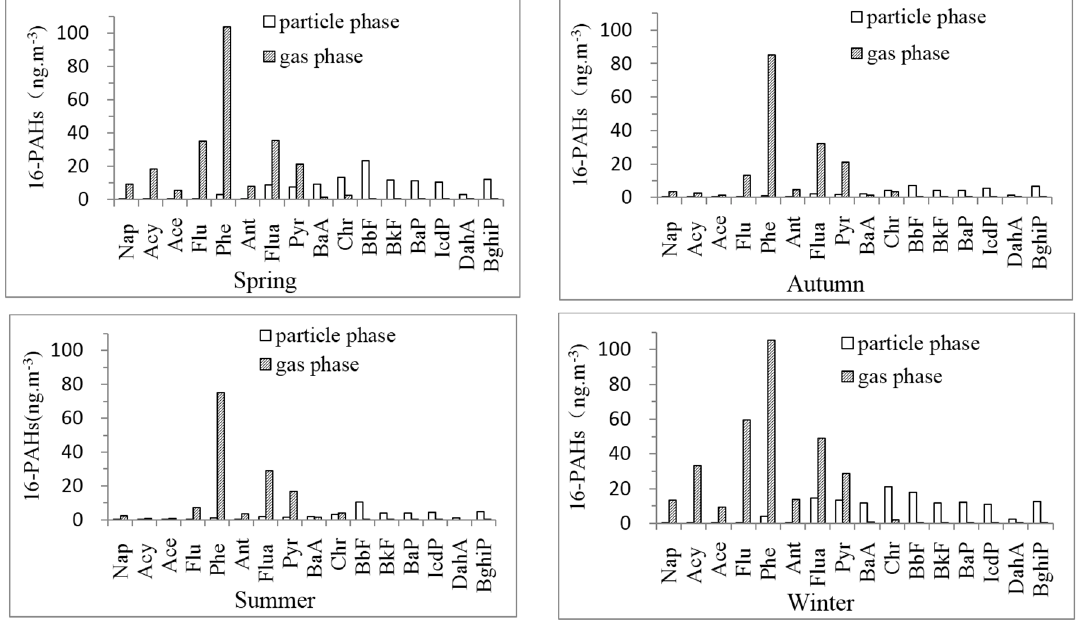
Figure 2. The concentration (ng·m − 3 ) of the 16 PAHs in the gas phase and particle phase during the different seasons . The PAHs are shown in order of decreasing molecular weight. (Note: Naphthalene (Nap) Acenapthylene(Acy) Acenaphthene(Ace) Anthracene(Ant) Benzo[a]anthracene(BaA) Benzo[k]fluoranthene(BkF) Benzo[a]pyrene(BaP) Dibenz[a,h]anthracene(DahA)).